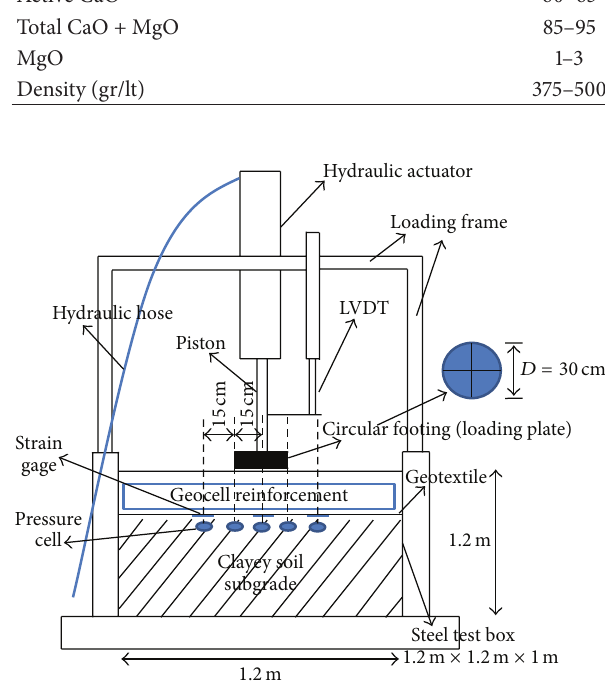
Figure 5: Schematic diagram for the set-up of the plate loading